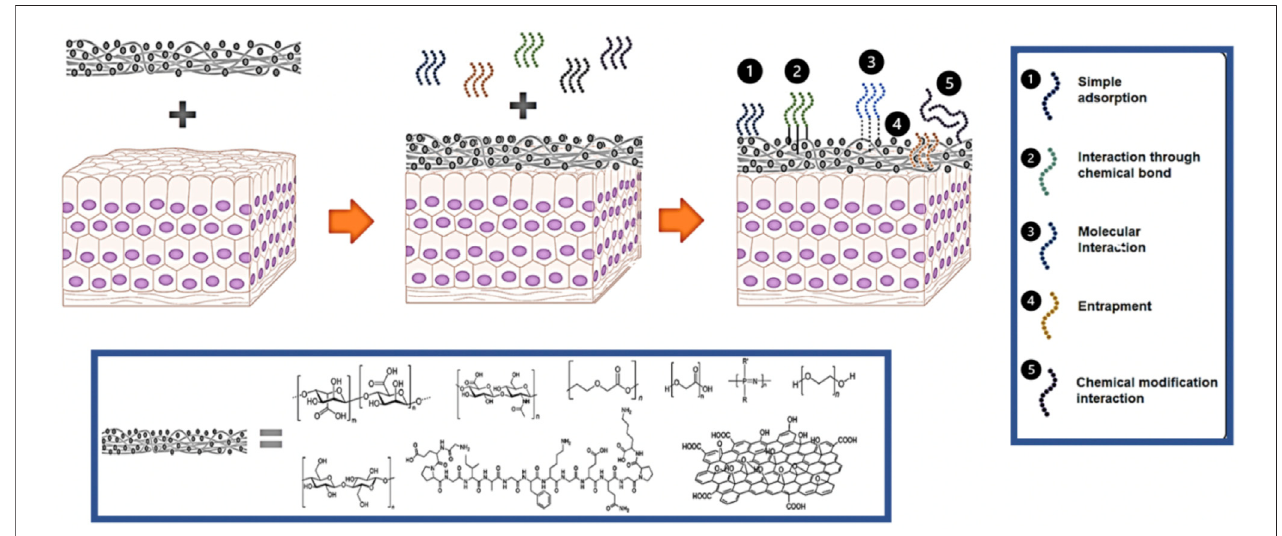
FIGURE2| Schematicrepresentationfortheinteractionsbetweenmaterialsandpeptides.Peptidescanbeaddedtoabiomaterialthrough1)simpleadsorption,2) covalent conjugation, 3) molecular interactions, 4) entrapment, or through 5) chemical modi fi cations.